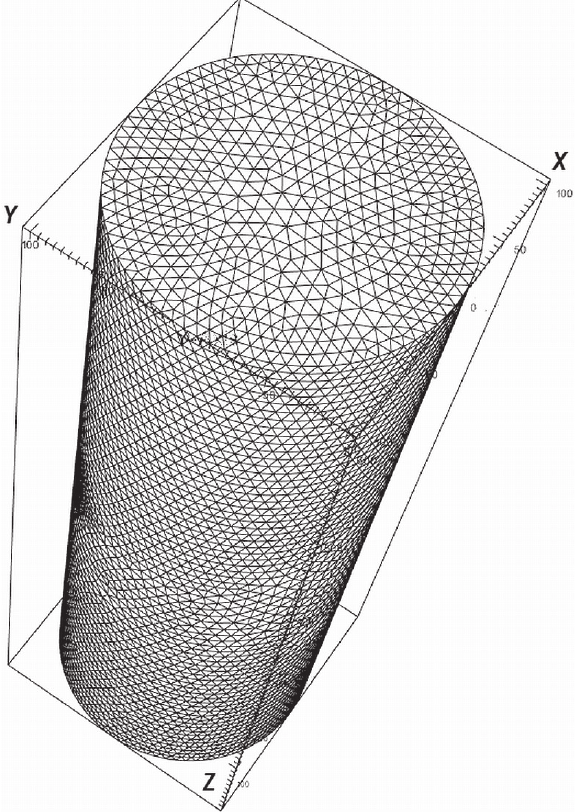
Figure 1. An example of the region decomposition into a finite number of